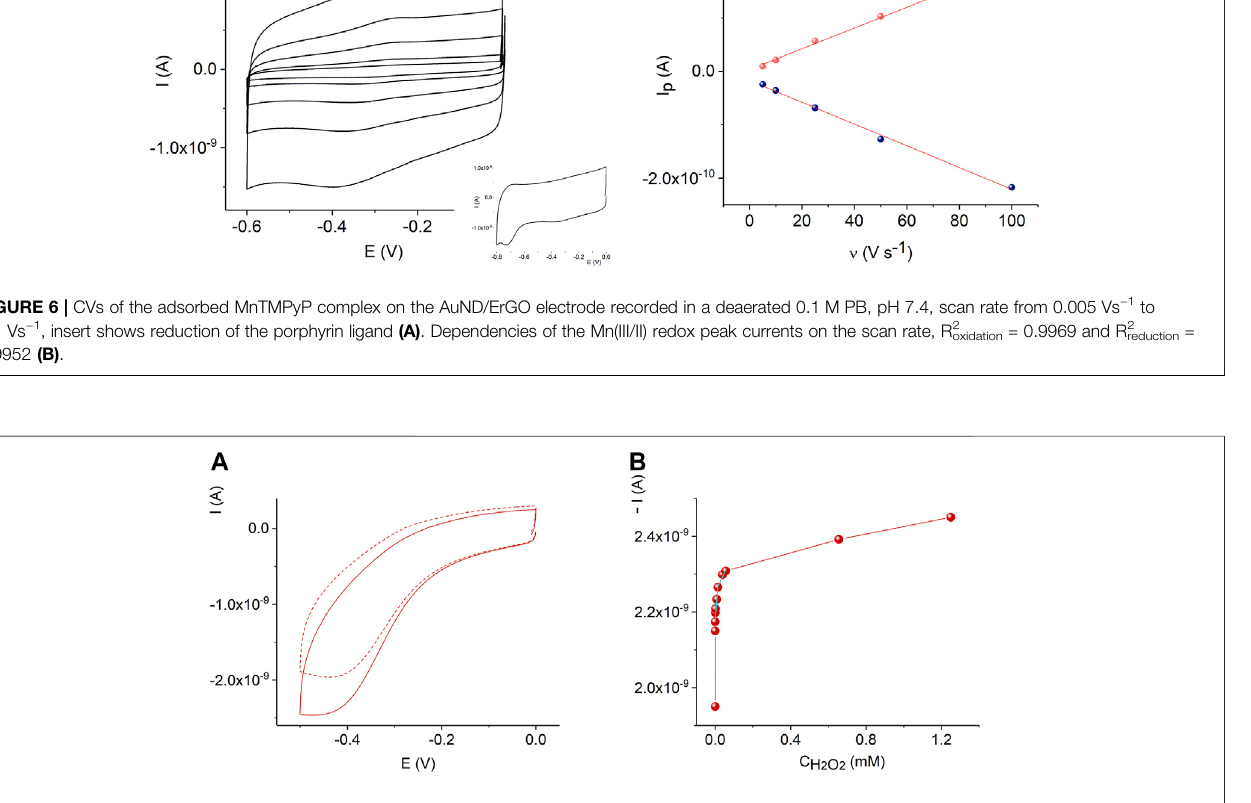
FIGURE7| Cyclic voltammograms oftheAuND/ErGO/MnTMPyP electrochemicalsystemwith 0 M (dashed line) and 1.2 mM (solid line) H 2 O 2 (A) . Dependenceof the current on the concentration of hydrogen peroxide at -0.45 V for the AuND/ErGO/MnTMPyP (B) . Other conditions: 0.1 M PBS, pH 7.4, scan rate 0.05 Vs − 1 , measurements were performed at ambient